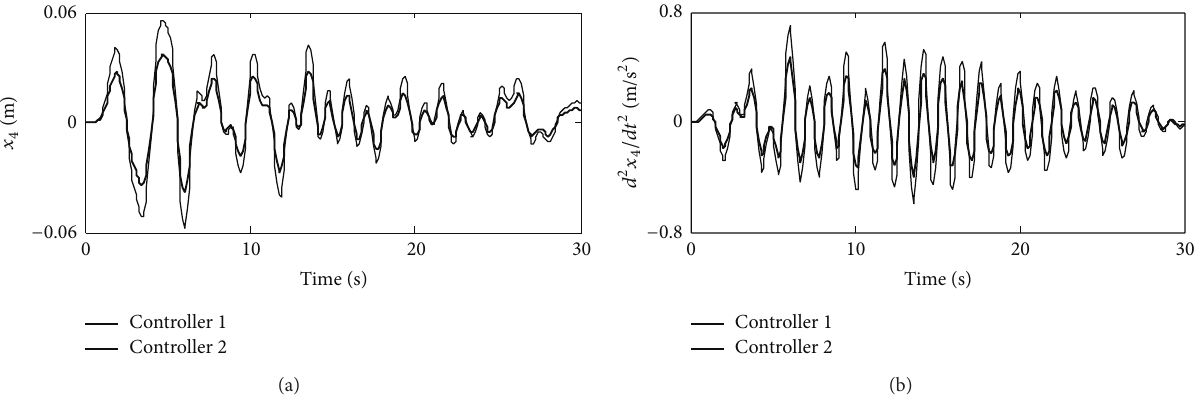
Figure 9: Controller 1 and uncontrolled cases frequency responses of 𝑥 4 .